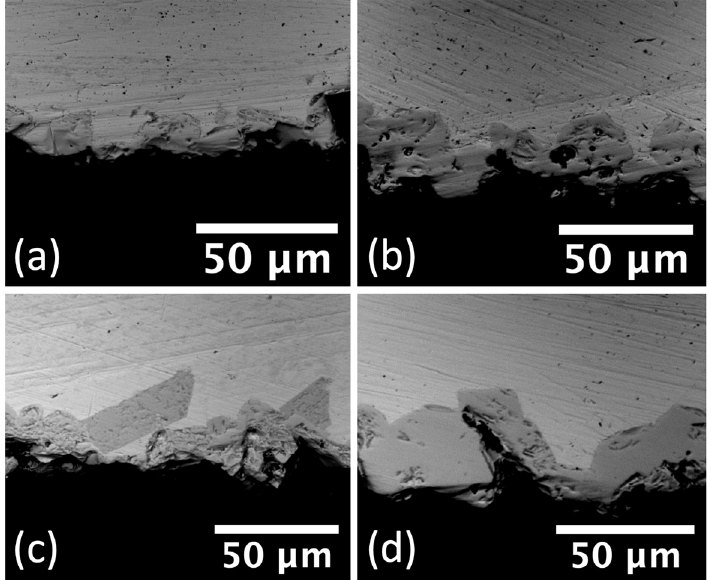
Figure 2. SEM images of carburized Zr samples through pack carburization at 1623 K for ( a ) 6 h, ( b , c ) 12 h, and ( d ) 18 h.